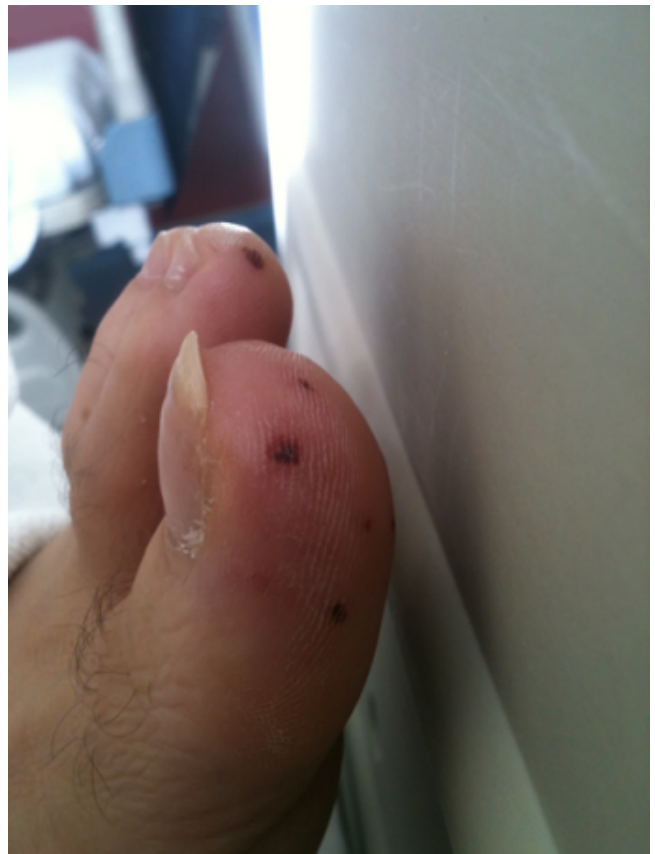
Figure 1: Hemorrhagic cutaneous